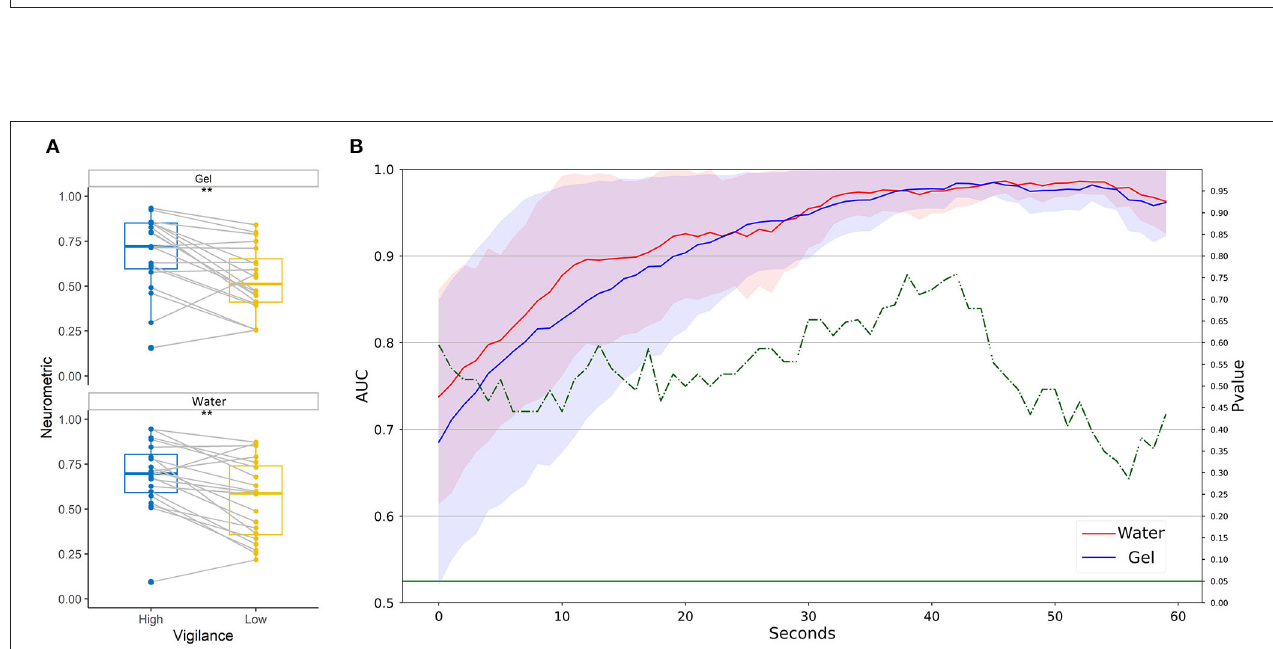
FIGURE 7 | Stress discrimination between low and high conditions in laboratory settings. (A) Statistical comparison has been performed for water-based and gel-based Neurometrics. The asterisks show the results of the Wilcoxon signed-rank test (* p < 0.05, **** p < 0.0001). (B) AUC values obtained by water (in red) and gel (in blue) electrodes for different time resolutions (1–60s). The solid lines represent the median of the AUC among the participants. The shadows represent the mean absolute deviation of the AUC across participants. The dashed green line represents the results in terms of p -values of the Wilcoxon signed-rank test. The threshold of significance ( p = 0.05) has been highlighted in the same color.